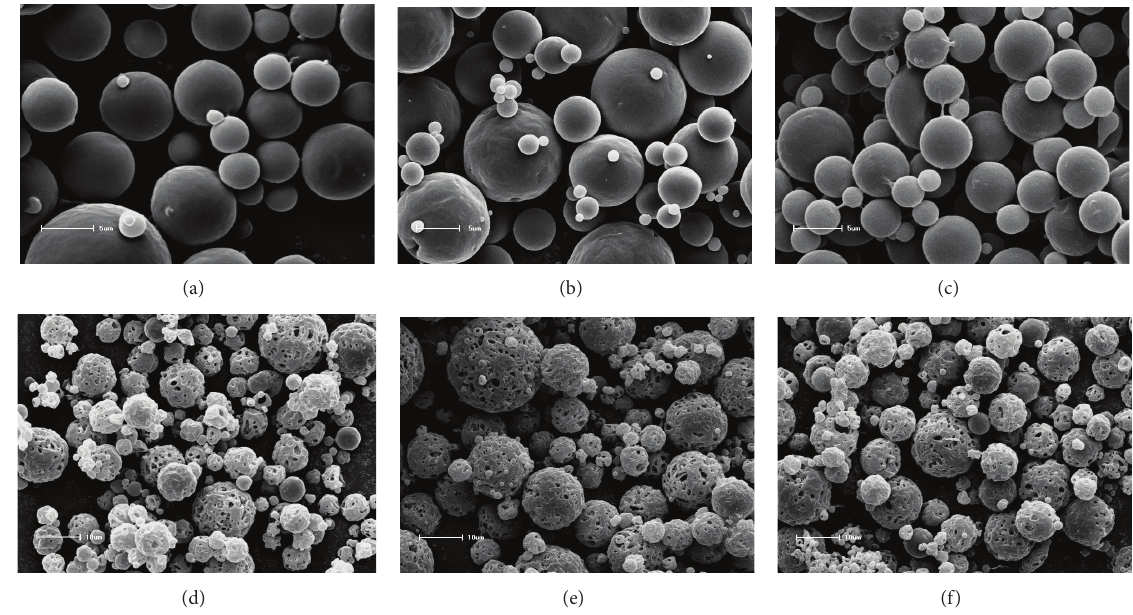
Figure 2: SEM photomicrographs of PCL and PHBV microparticles: PCL-M0 (a), PCL-M5 (b), PCL-M10 (c), PHBV-M0 (d), PHBV-M5 (e), and PHBV-M10 (f).